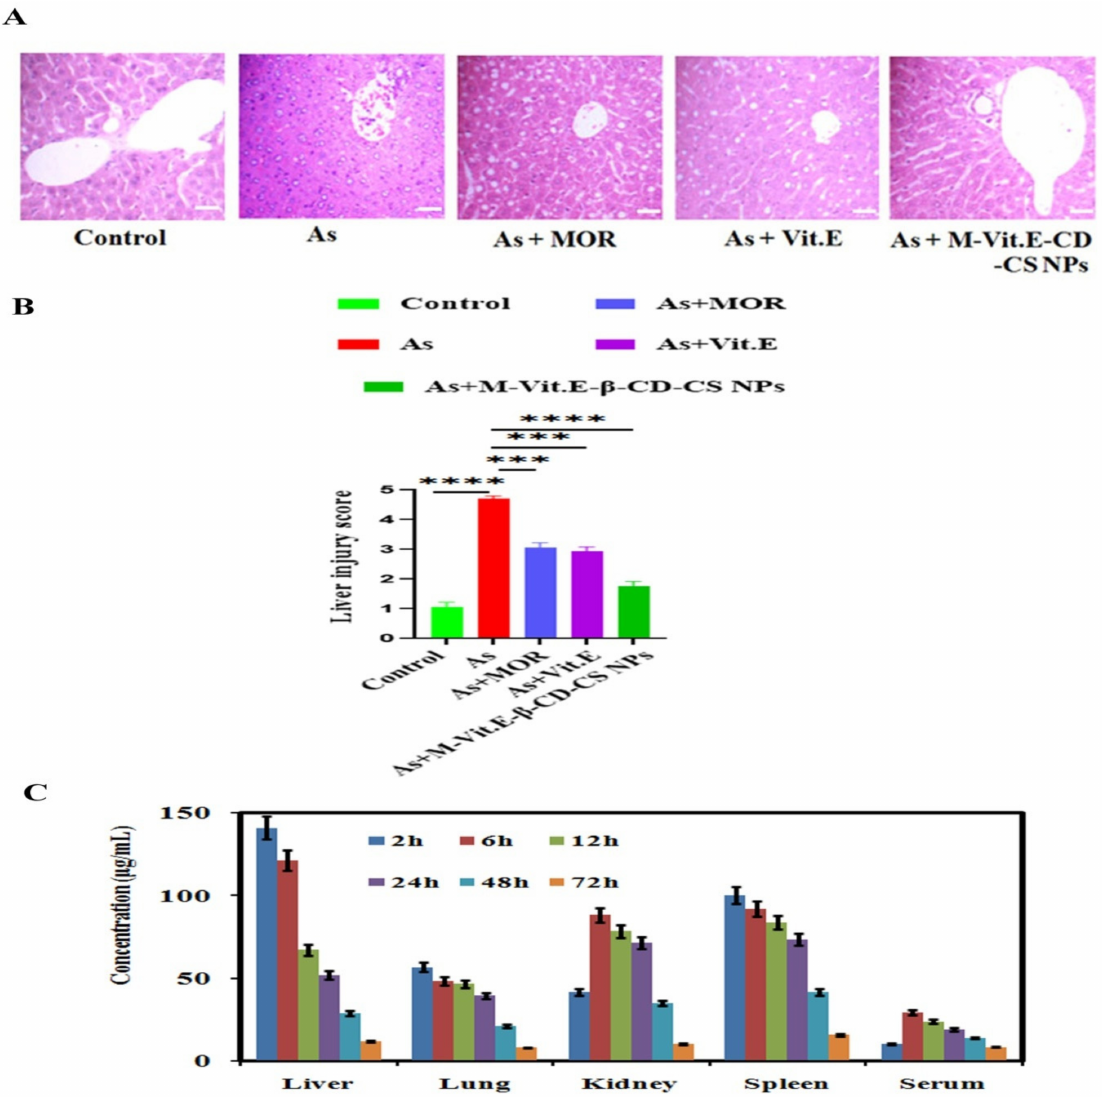
2.9. M-Vit.E-CD-CS NPs Ameliorate Liver Tissue Damage Induced by Arsenic The histopathological changes were analyzed by using H&E staining in the liver tissue section. The control liver tissue showed the cords of the normal hepatocytes in which sinusoid lines were looking normal by Kupffer cells, whereas diffused Kupffer cells, vascular changes, and infiltration of inflammatory cells showed arsenic exposure, indicating critical liver damage (Figure 8A). The repair of liver tissue took place in arsenic-intoxicated mice injected with M-Vit.E-CD-CS NPs as compared with the free MOR and vitamin E treated mice (Figure 8A).